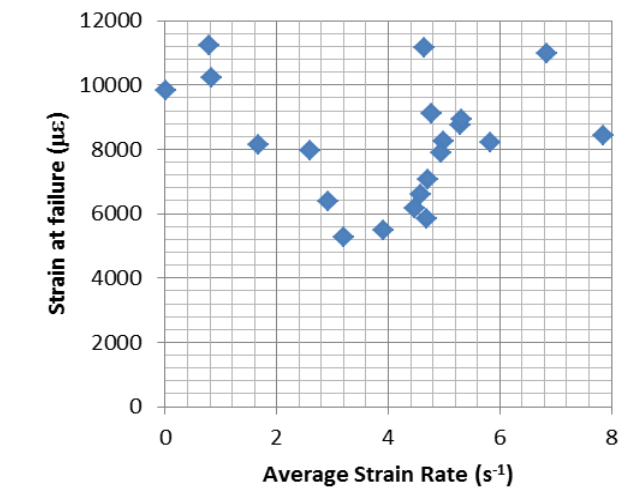
Figure 10. Strain at failure vs. average strain